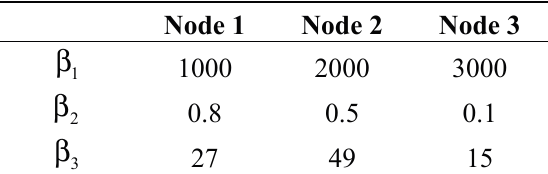
Table 1. The raw data.